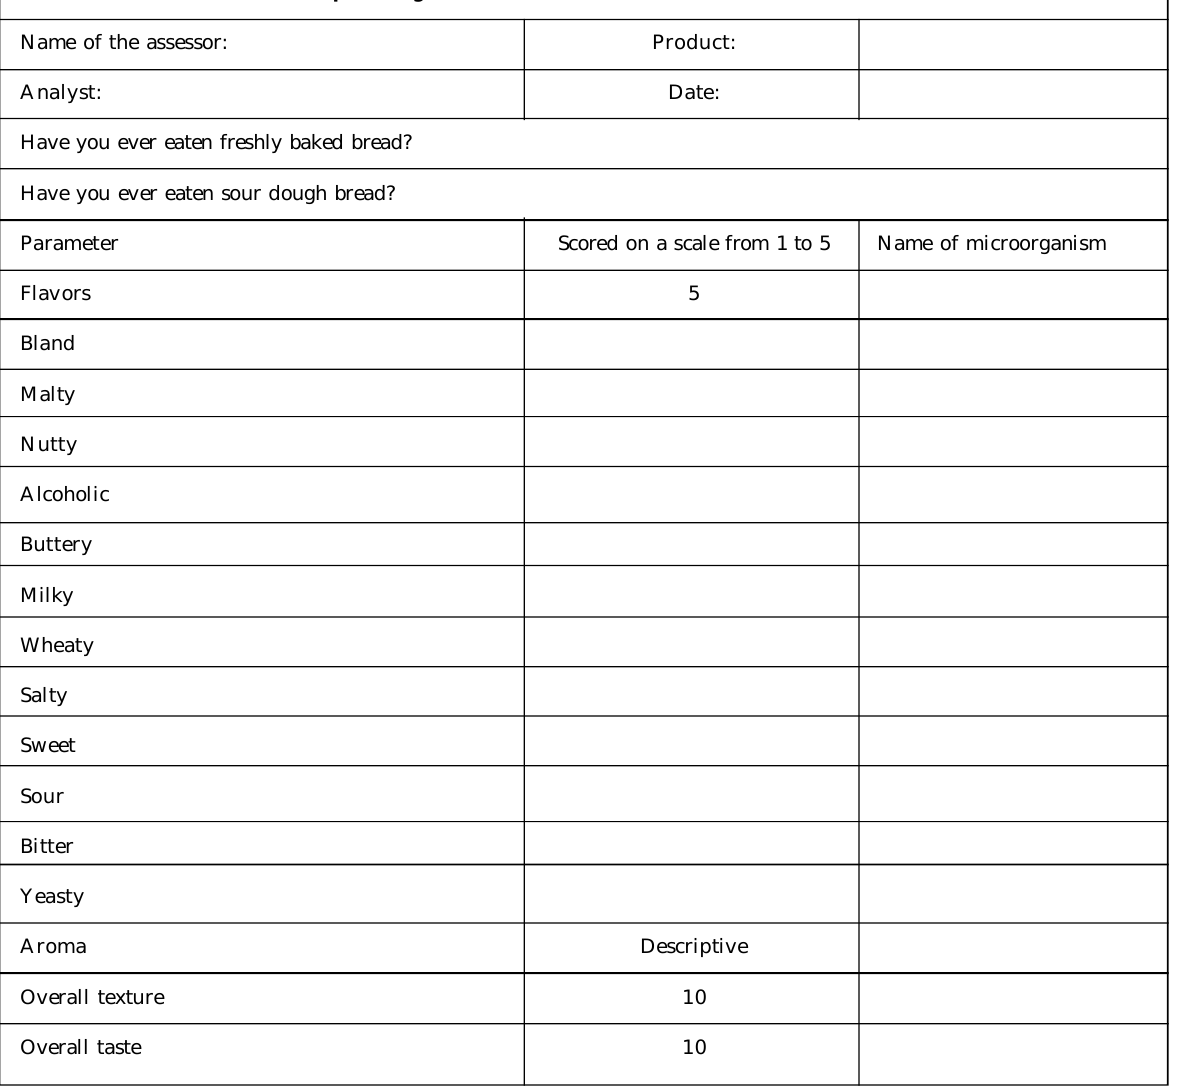
Table 1: Rubric used for taste